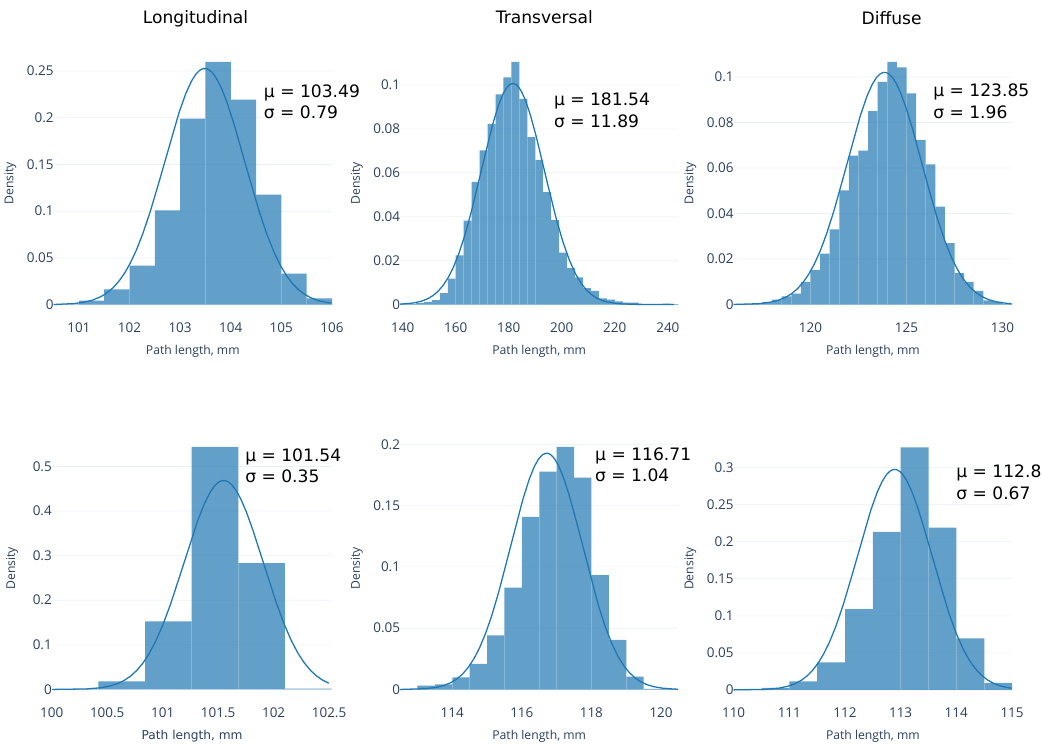
Figure 10. Normalized histograms of the shortest path for the longitudinal propagation and transversal propagation for n = 4 node length fibrosis and for n = 1 diffuse fibrosis of the same 30% density in the monolayer ( upper ) and multilayer ( lower ) models. 5000 shortest possible trajectories calculated in 5000 fibrosis matrices are used for each